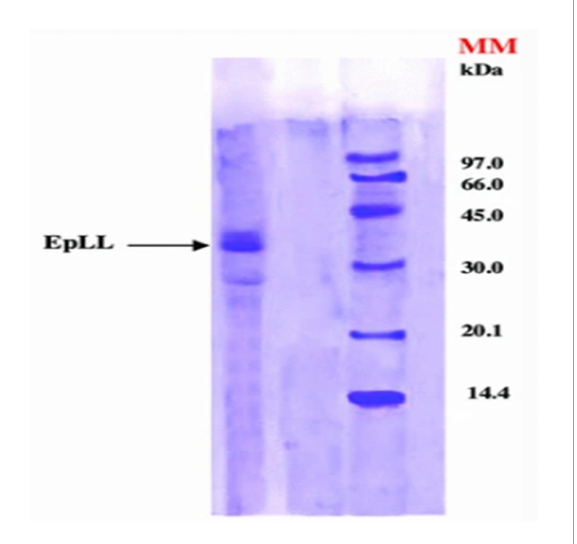
FIGURE8 The molecular weight of the lipase from E. peplus latex (EPLL) obtained by Sodium dodecyl sulfate–polyacrylamide gel electrophoresis (SDS-PAGE) (Lazreg Aref et al., 2014).